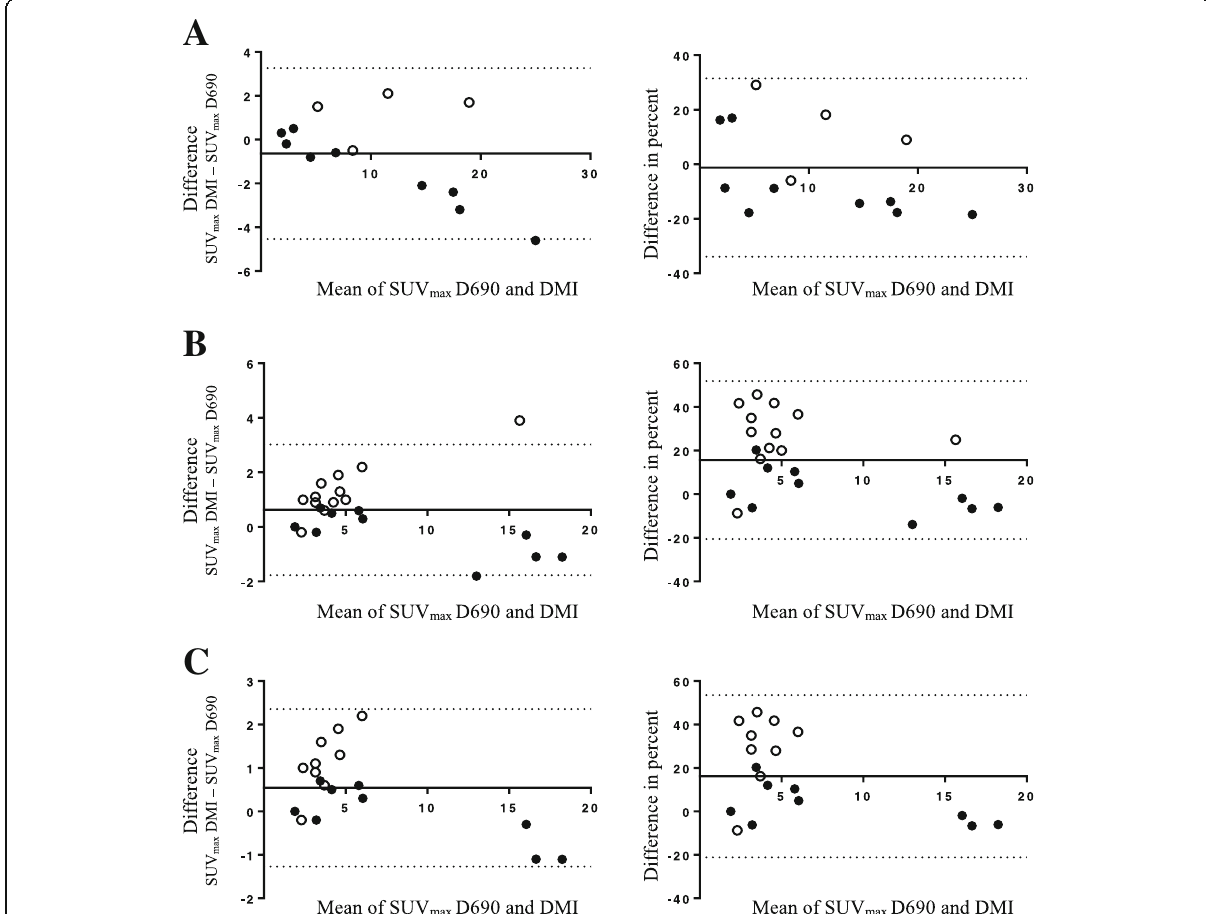
Fig. 2 Bland-Altman plots comparing SUV max between the Discovery 690 (D690) and Discovery MI (DMI). Absolute differences (left column) and differences in percent (right column) between SUV max on D690 and DMI ( y -axis) vs. the average of D690 and DMI ( x -axis). White circles indicate lesions from patients first examined on the D690 and black circles first examined on the DMI. The DMI produced higher values for SUV max in all lymph nodes ( b ) and lymph nodes less than 10 mm on short axis ( c ) but not in primary lesions ( a